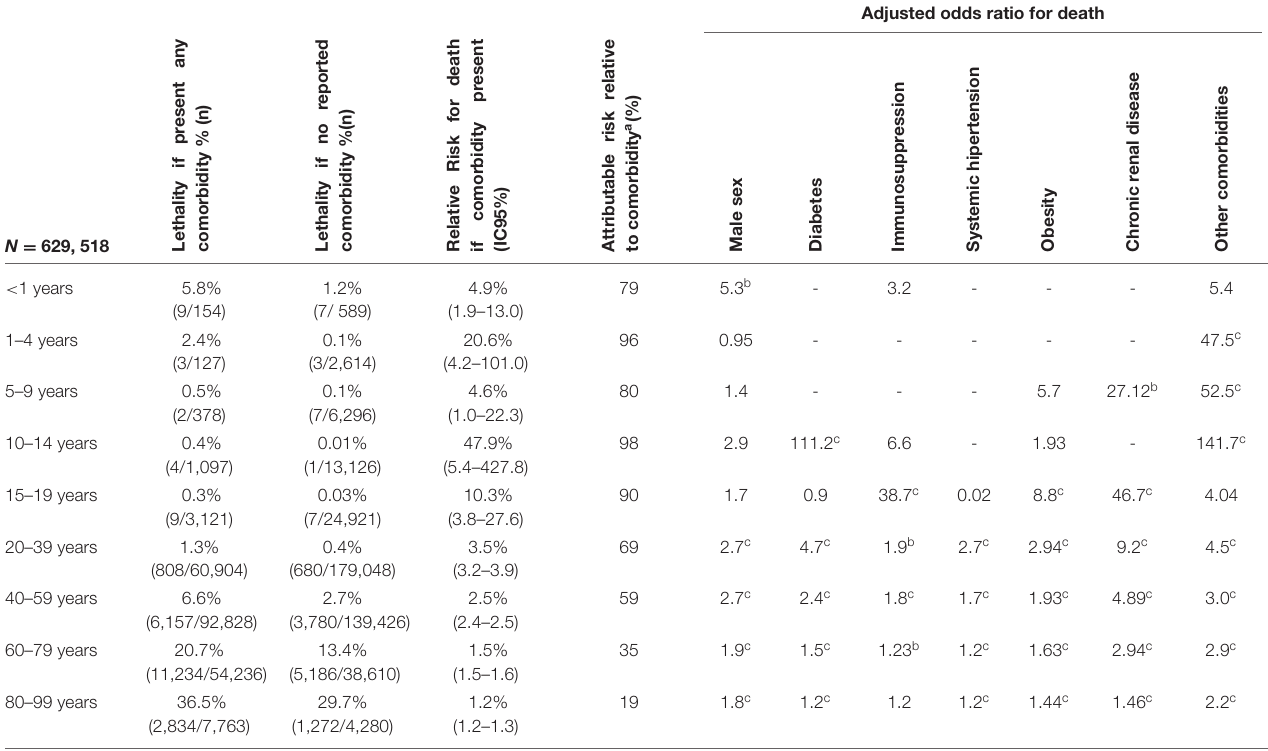
TABLE 2 | Death risk by comorbidities in SARS-COV2 confirmed cases.